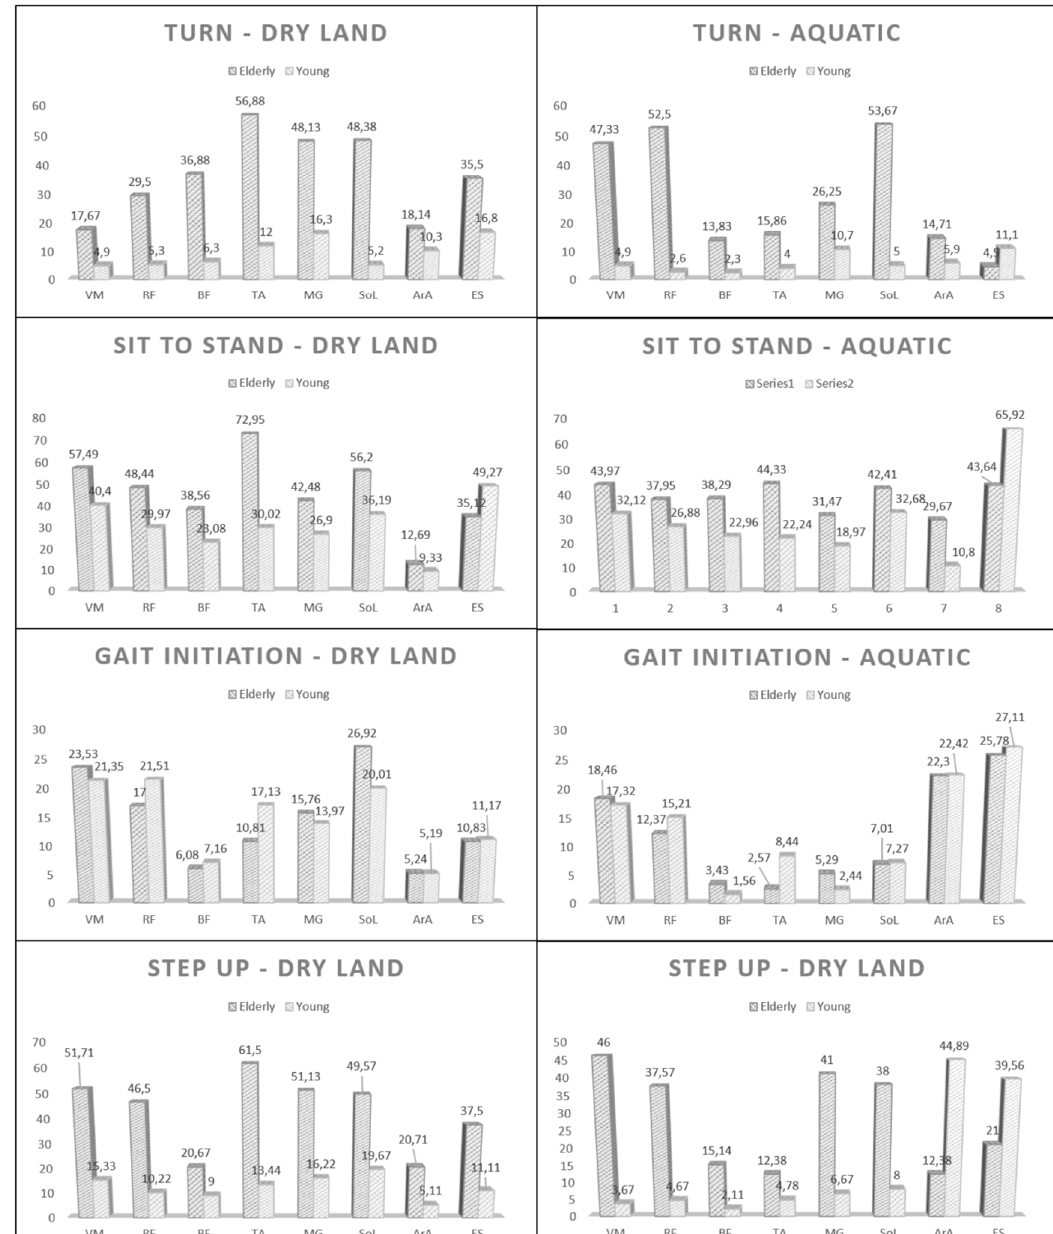
Figure 3. Comparison, within the same environment (dry land or aquatic) of normalized muscle activation between the teo groups analyzed.